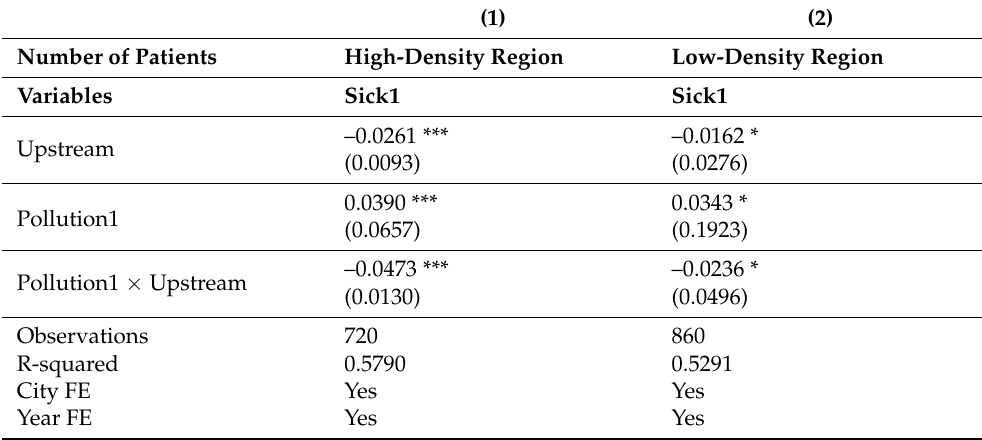
Table A8. Effect of pollutant emissions on health of residents in various types of